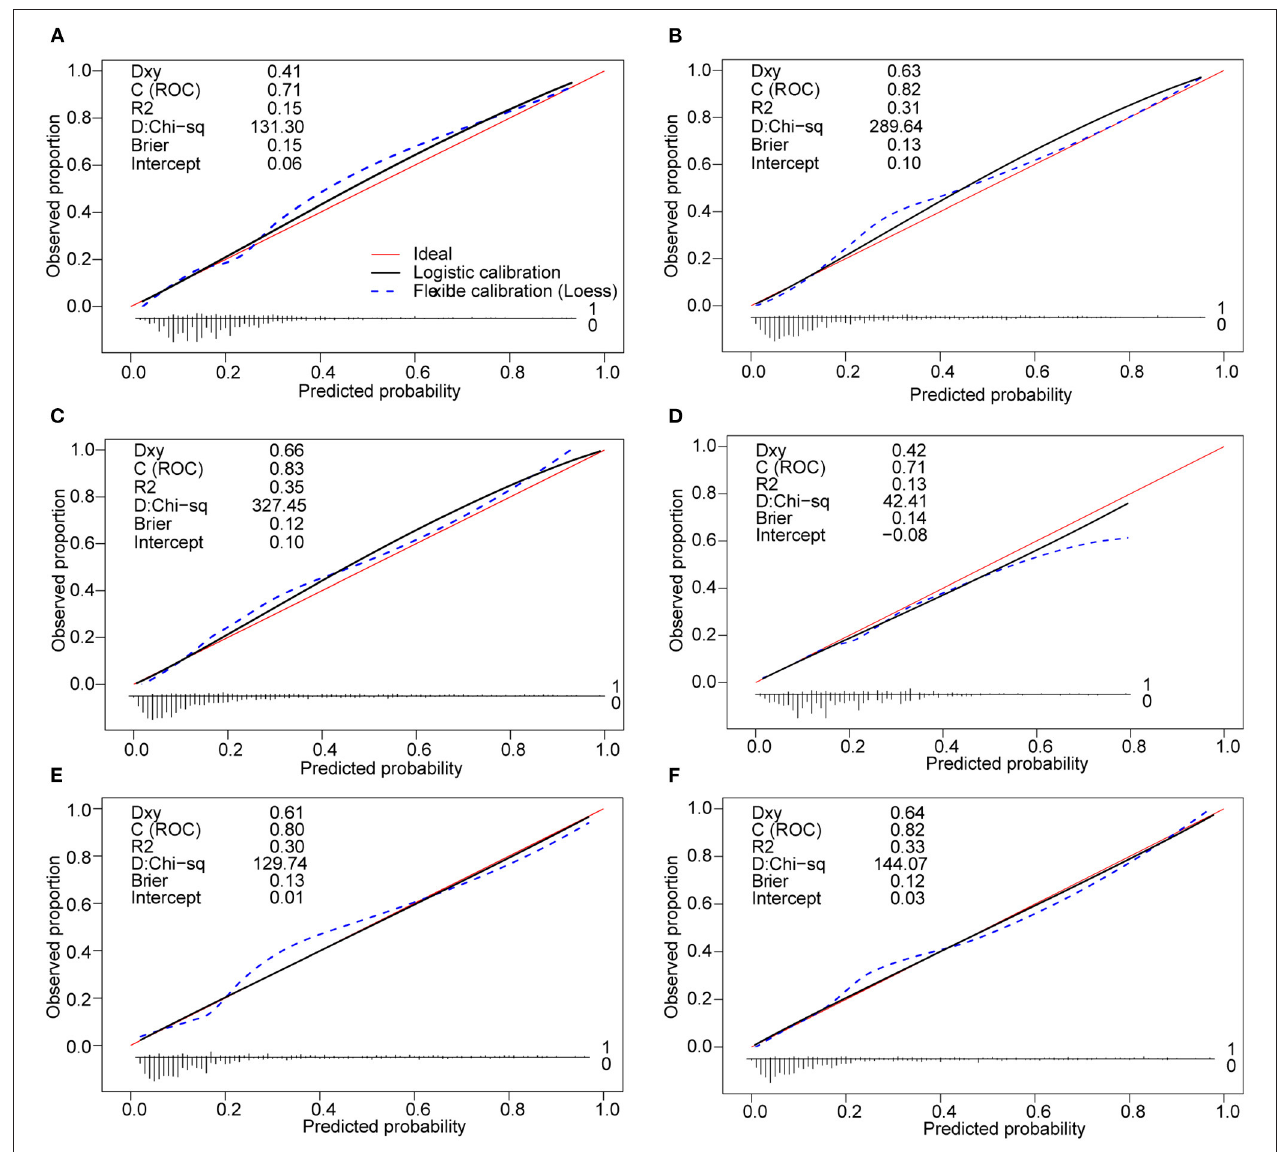
FIGURE 4 | Calibration curves of the clinical nomogram and the model with the addition of lab-score in each cohort. (A) Calibration curve of the clinical nomogram in the derivation cohort. (B) Calibration curve of the lab-score nomogram in the derivation cohort. (C) Calibration curve of the clinical-lab nomogram in the derivation cohort. (D) Calibration curve of the clinical nomogram in the validation cohort t. (E) Calibration curve of the lab-score nomogram in the validation cohort. (F) Calibration curve of the clinical-lab nomogram in the validation cohort. Calibration curves depict the calibration of each model in terms of the agreement between the predicted risks of IAID and observed outcomes of IAID (IAID, infectious, and inflammatory